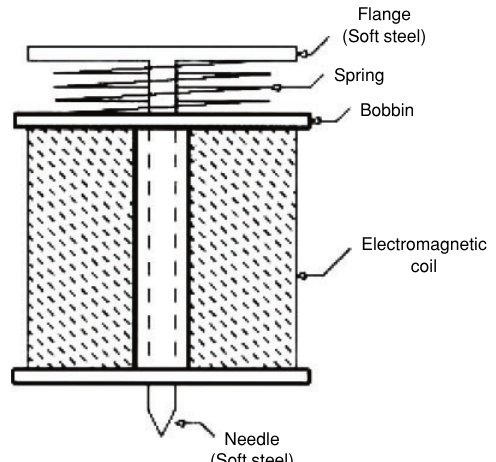
Figure 4 Tactile display basic element.